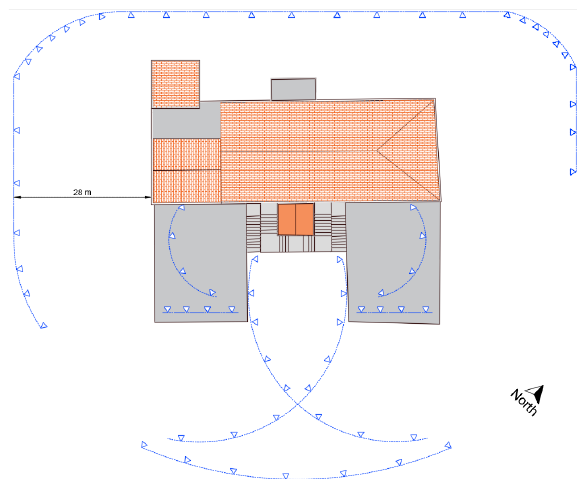
Figure 4. Terrestrial camera network.